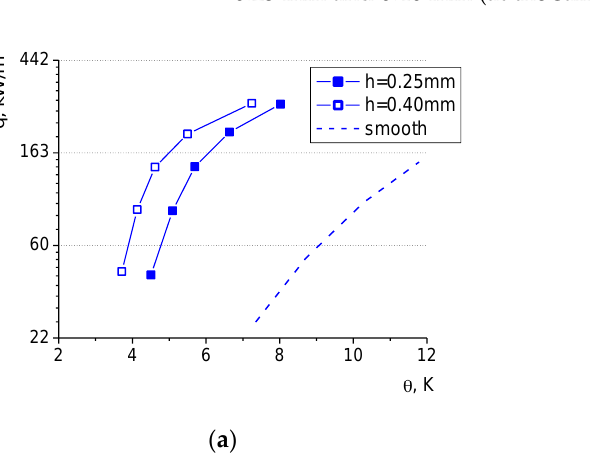
Figure 19. Boiling curves for two microfin heights (0.25 mm and 0.40 mm) for ( a ) water and ( b ) ethyl alcohol.